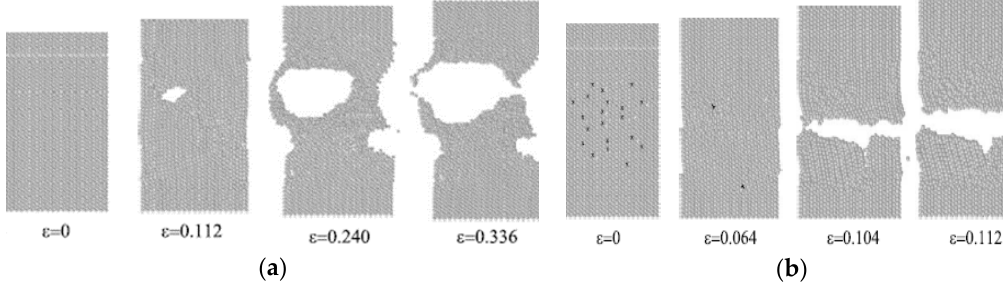
Figure 9. Influence a number of defects in material on the overall elongation of the test specimen: ( a ) without failures; ( b ) with failures ( ε —relative deformation).